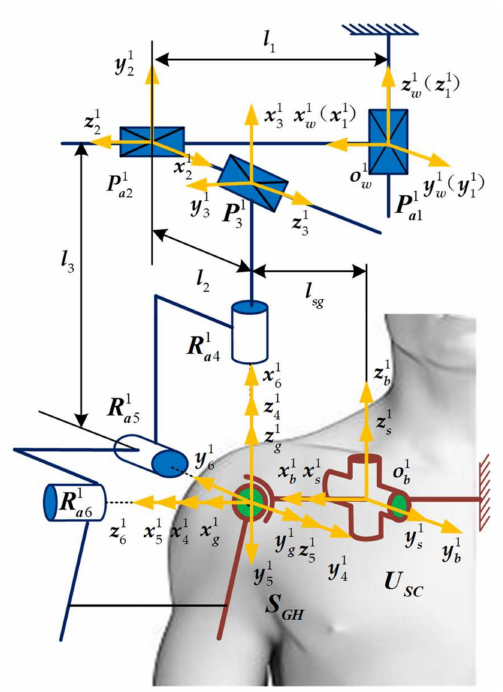
Figure 8. 2 P a 1 P 3 R a mechanism and upper limb closed